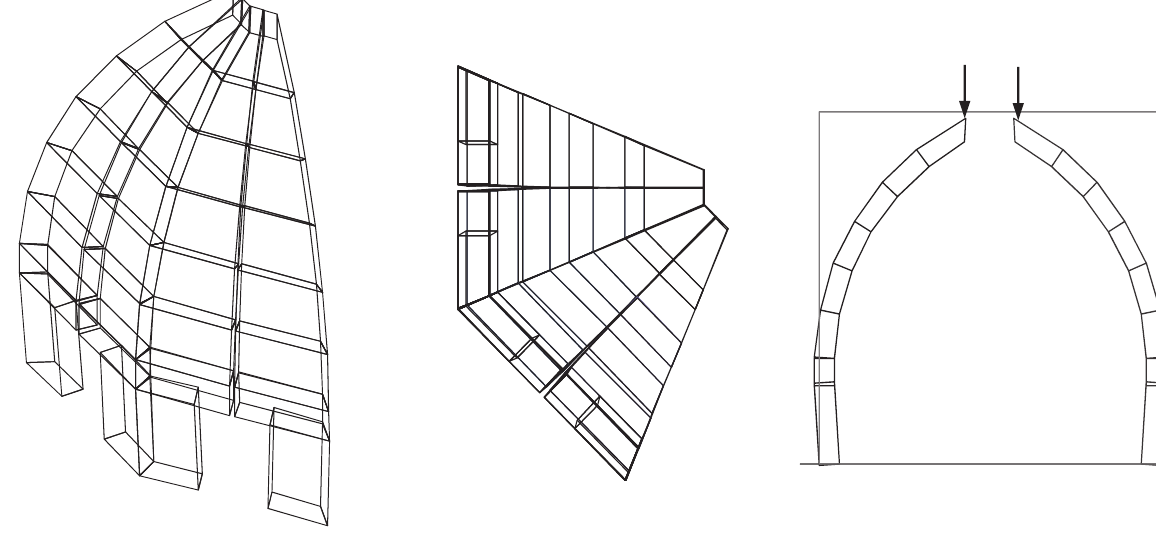
Figure 14: Collapse mechanism for case 2 (no failure at ribs / Lf=2 / Nh=0 / sT=1.5 / multiplier α =14.224)